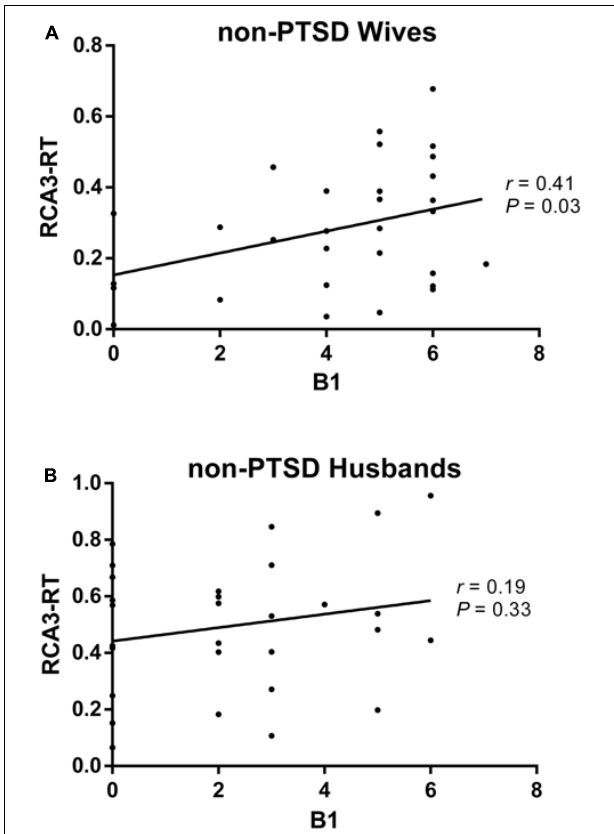
( F = 3.73, p = 0.028). The correlation between the RCA3-RT FC and B1 score was also significant only in wives without PTSD ( p = 0.04).